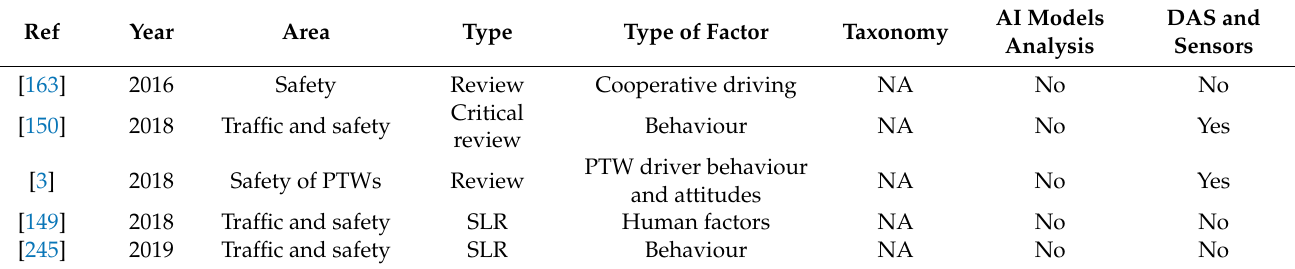
Table 9. Present comparison between our works versus review